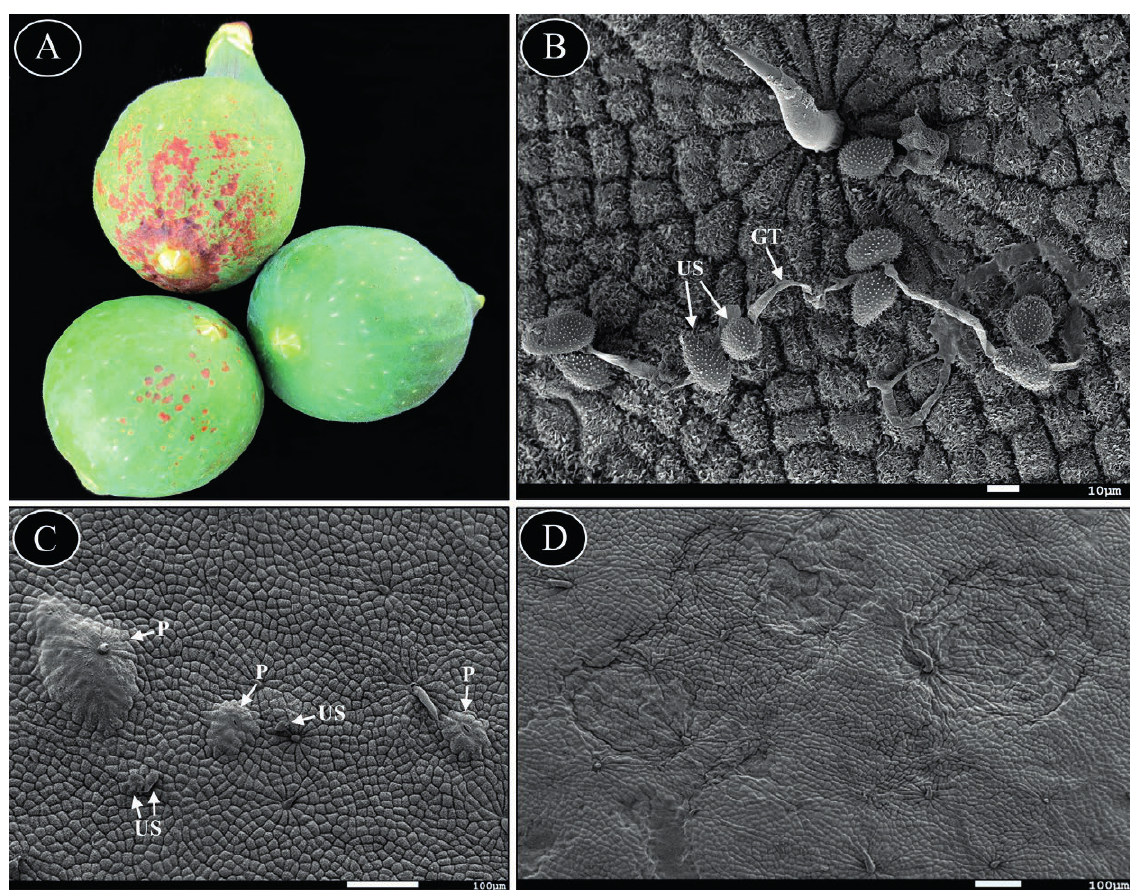
Figure 8. A, Fruit of fig cultivar Kadota after applying dry urediniospores of Phakopsora nishidana to young developing figs, showing blem- ishes (top and bottom left fruits), while the fig on the right represents an uninoculated control. B and C, scanning electron micrographs (SEMs) 96 h post inoculation, of a germ tube (GT), urediniospores (US) and blister-like pustules (P). D, SEM of sunken leaf lesions at 16 d post